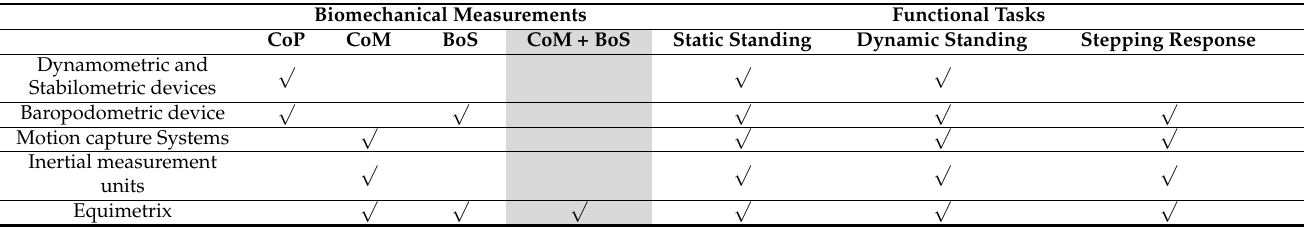
Table 1. State of the art technologies suitable for the measurements of biomechanical parameters: Center of Pressure (CoP), Center of Mass (CoM), Base of Support (BoS), and “CoM + BoS” which corresponds to the combination of CoM related measures with BoS information. Static standing: maintaining upright posture. Dynamic standing: feet position fixed while upper body is moving within the limits of stability. Stepping response: during such tasks both upper and lower limbs can move intentionally (planned task) or reactively (response to external